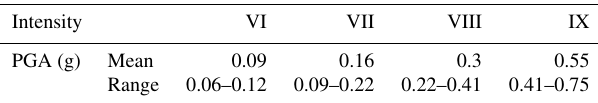
Table 8. The latest intensity–PGA relation derived by traditional practice for mainland China (Ding et al.,